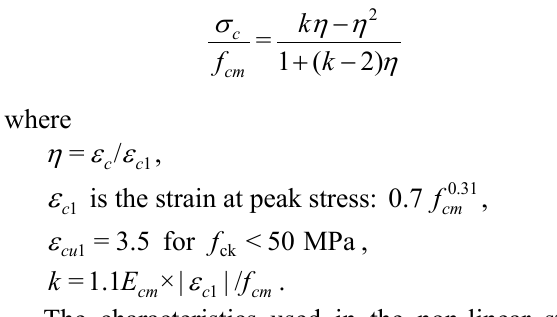
Fig. 2. Stress-strain relation for non-linear structural analysis